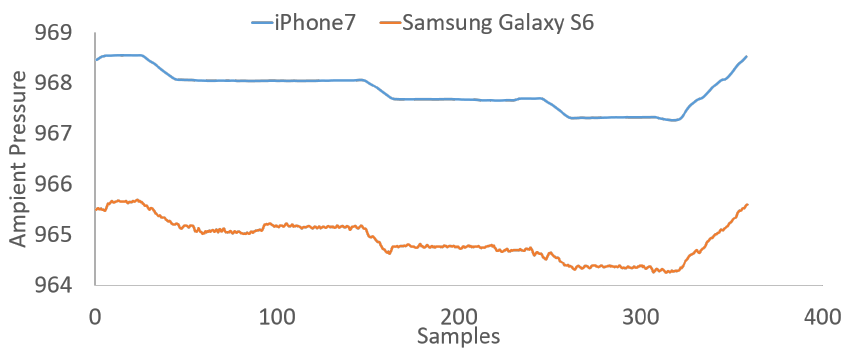
Figure 12. Data collected from an iPhone 7 and a Samsung Galaxy S6, while the user had climbed three floors upwards and the same number of floors downwards.